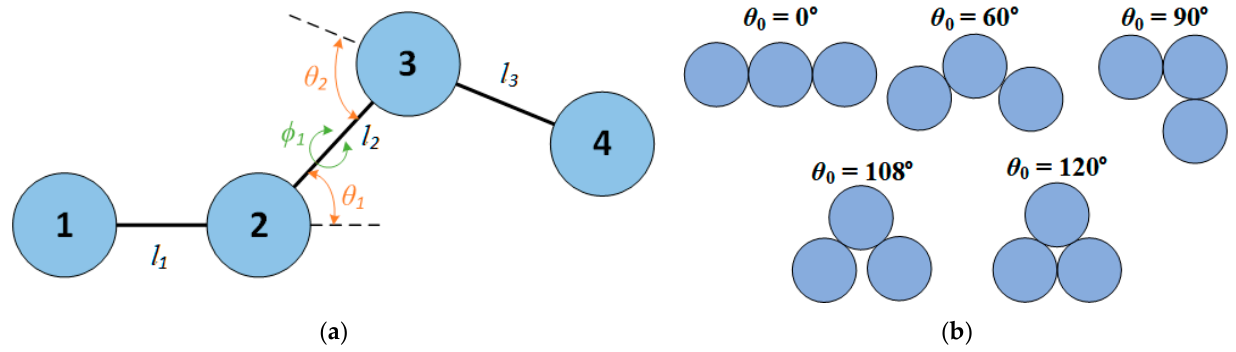
Figure 1. ( a ) Scheme of the bond geometry of a linear sequence of four monomers, indicating bond lengths, l , bending angles, θ , and torsion angles, φ . ( b ) Schematic representation of trimers having equilibrium bending angles ( θ 0 ) studied in the present